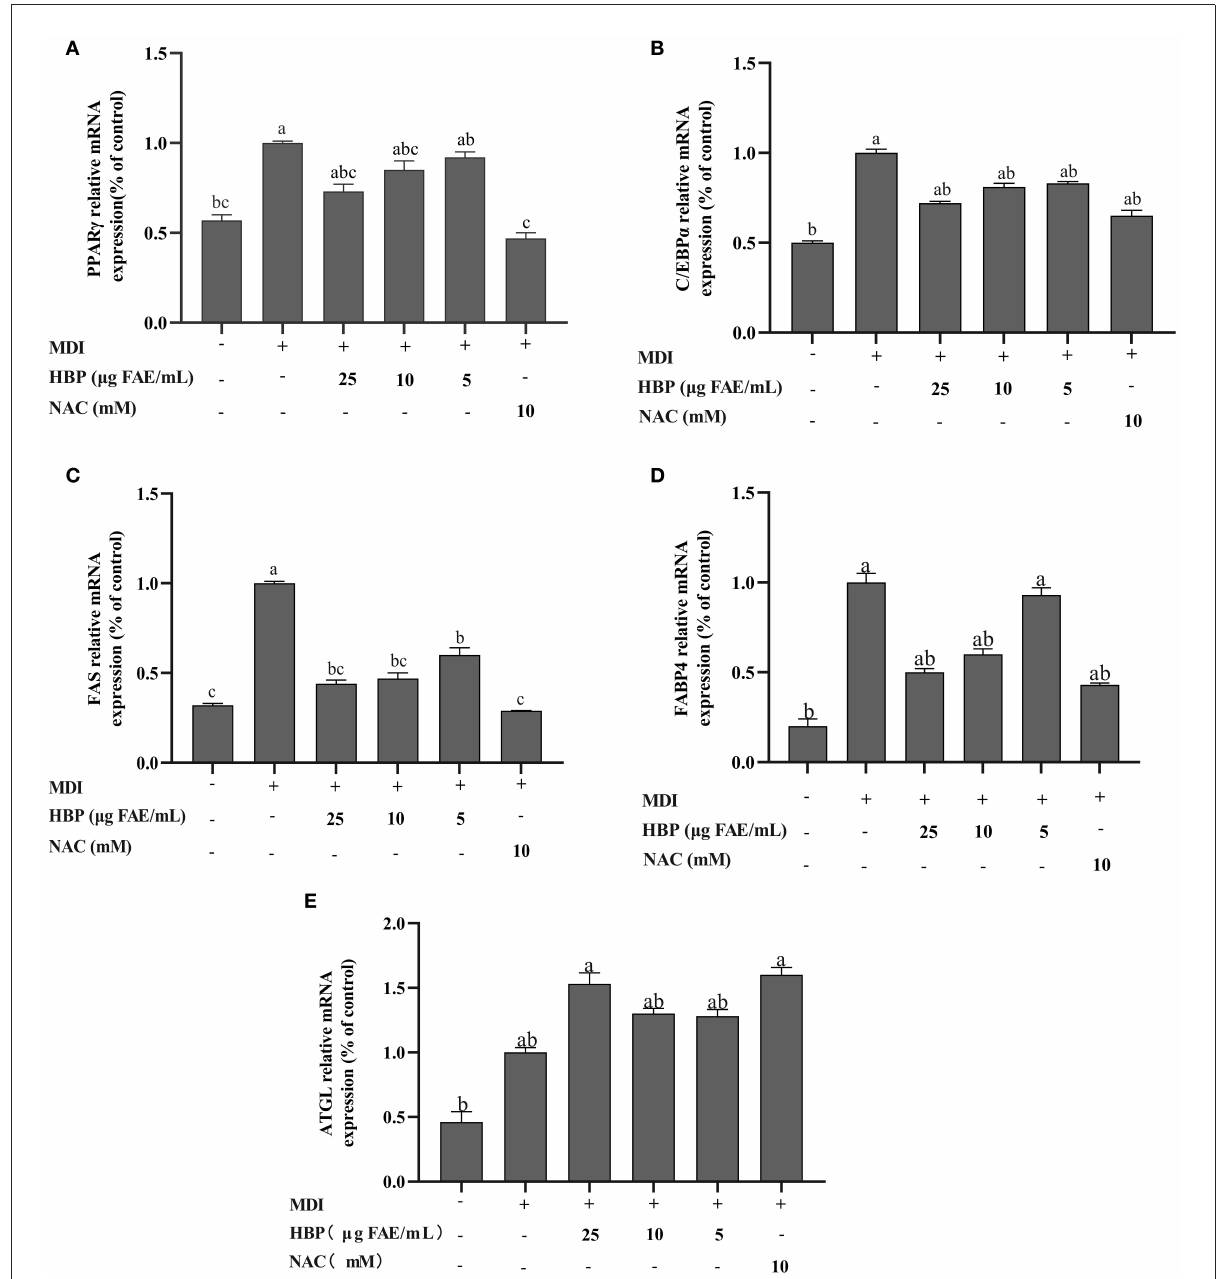
FIGURE6 Effect of HBP extract on the mRNA expression of adipogenic genes in 3T3-L1 adipocytes. The transcript levels of (A) PPAR γ . (B) C/EBP α . (C) FAS. (D) FABP4, and (E) ATGL were measured by RT-qPCR. The data are presented as the mean significant differences ( P <